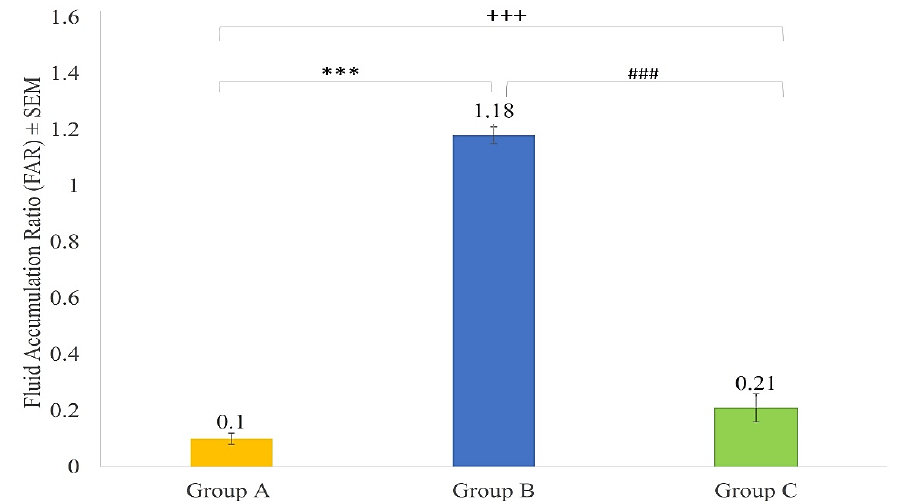
Figure 5. Fluid accumulation ratio (FAR) in the intestine of Group A (control group), Group B (unimmunised mice), and Group C (immunised mice) 24 h after the ETEC H10407 challenge. All the values are mean ± SEM (n = 6). *** = p < 0.001 compared to Group A. ### = p < 0.001 compared to Group B. +++ = p > 0.001 compared to Group C. (One-way ANOVA followed by Tukey post hoc test).